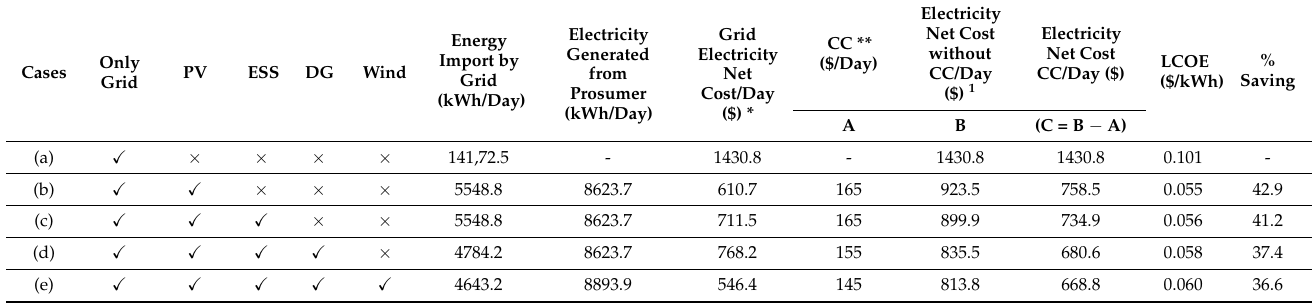
Figure 7. Scenario 1(c): Energy exchange with the grid. Table 3. Multiple case